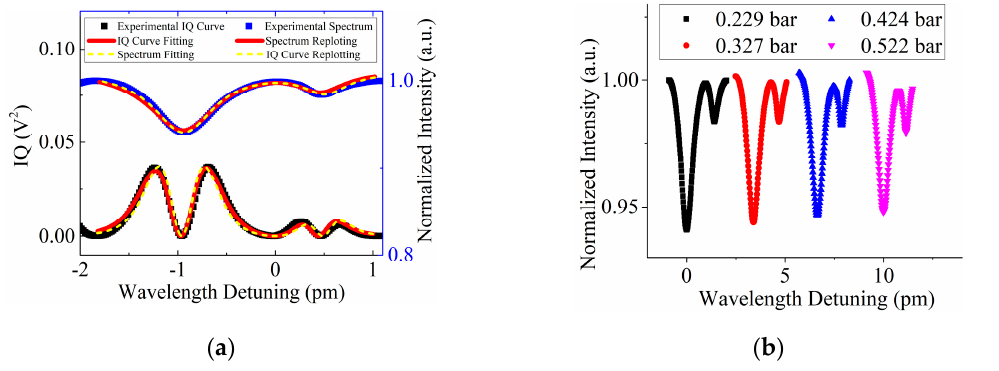
Figure 4. ( a ) Experimental spectrum (blue scattered line), its IQ curve (black scattered line), IQ fitting, replotted spectrum (red solid line), resonance fitting, and replotted IQ curve (yellow dashed line). The pressure is 0.229 bar. ( b ) The experimental spectrum shift as the MBR internal pressure (0.229, 0.327, 0.424, and 0.522 bar) increases. Table 3. Strongly coupled resonance fitting results.